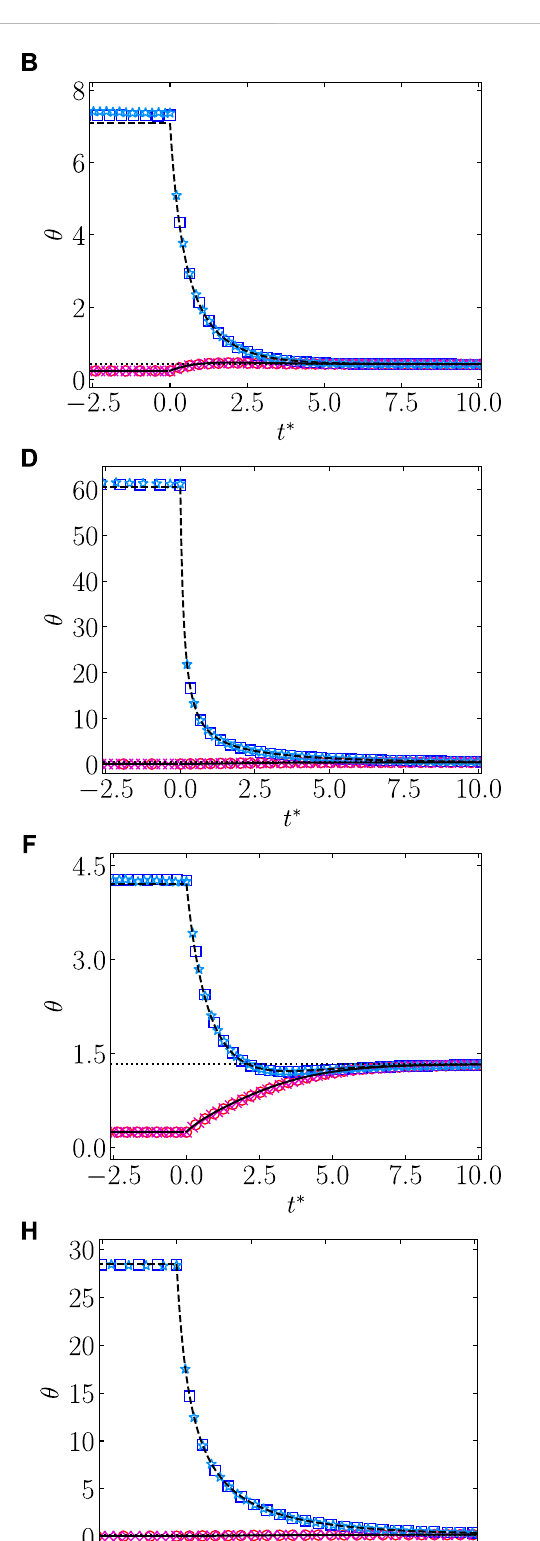
FIGURE 11 Time evolution of the reduced mean temperature T * and the rotational-to-translational temperature ratio θ for SME initialization protocol, as